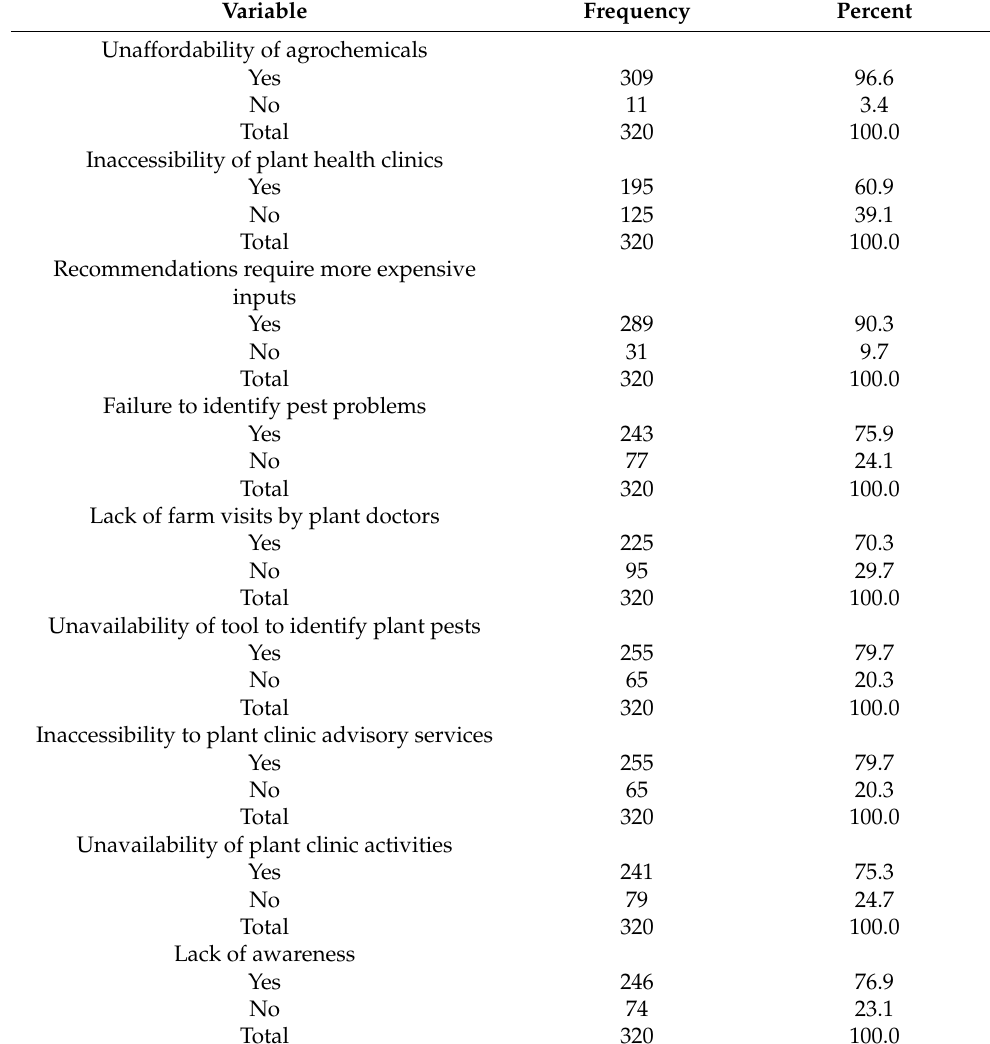
Table 6. Challenges confronted by smallholder